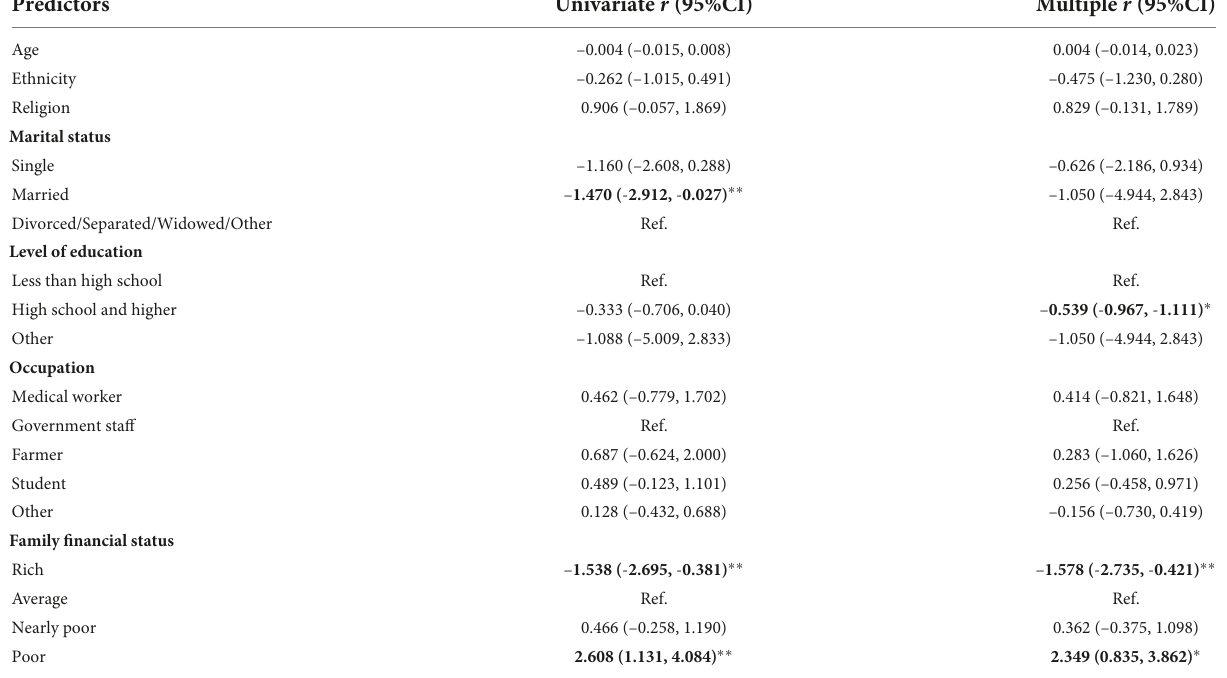
TABLE 5 Multiple linear regression model for the prediction of